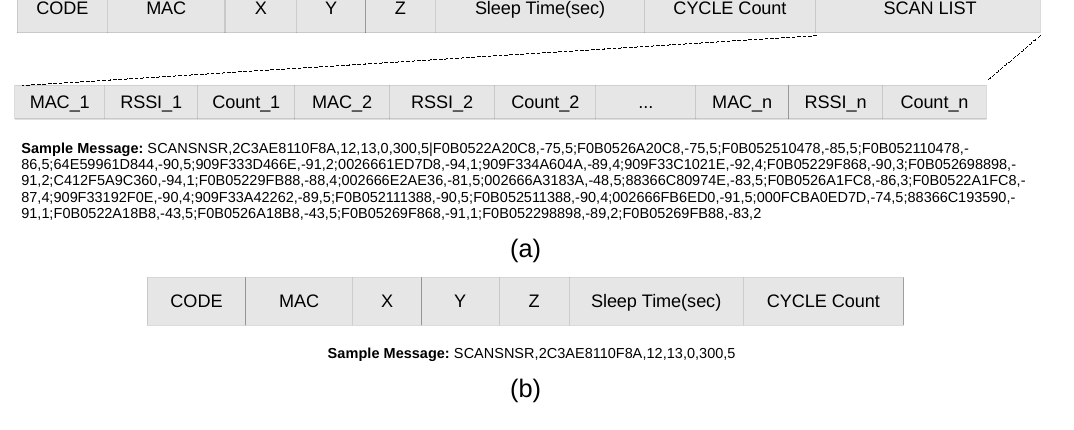
Figure 3. ESP8266 module configuration. ( a ) Received Signal Strength Indication (RSSI) scan message format. ( b ) Configuration update message